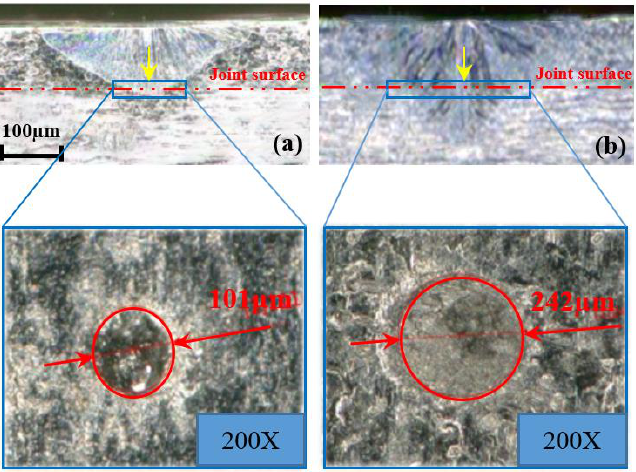
Figure 5. Experimental results of weld morphology and joint surface. ( a ) LEAM, ( b ) LECM.